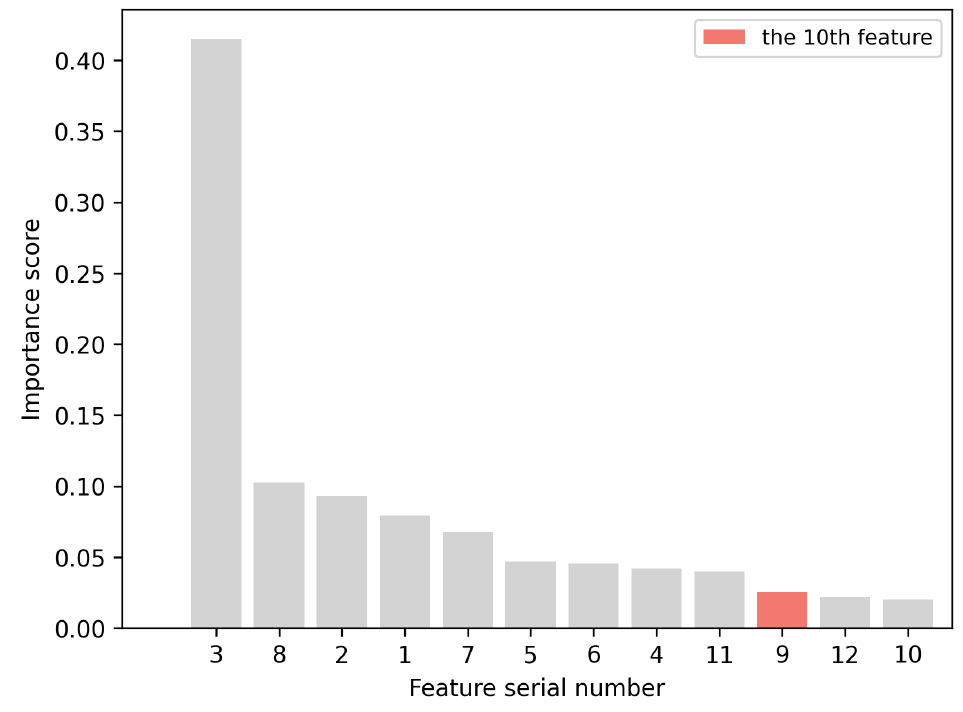
Figure 9. Feature importance